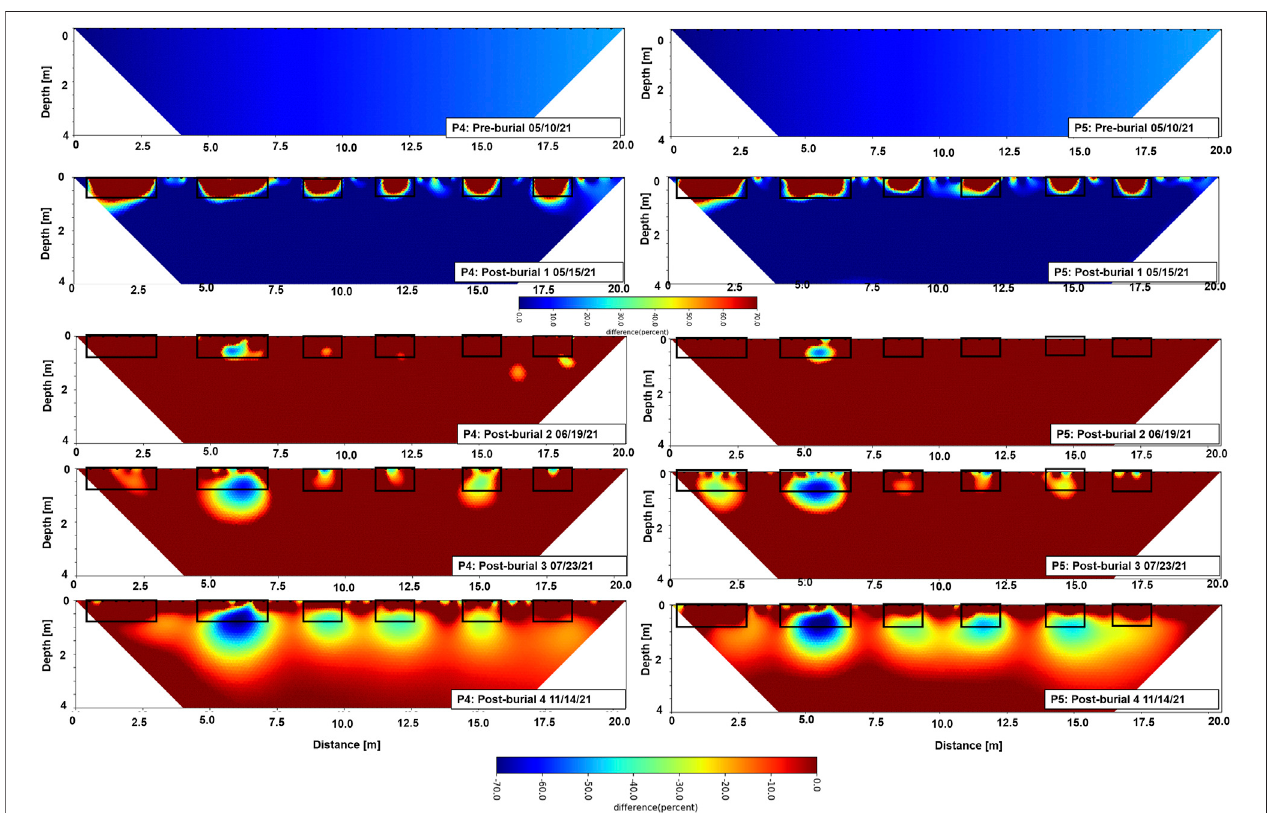
FIGURE8| 2Dtime-lapseresistivitydistributionoffortransects 4(left)and5(right)cuttingacrossallgraves. Percentagechangeswerecalculatedasthedifference between the original measurements on undisturbed ground minus the measurements over the burials, divided by the original measurements. It is to be noted that the scale for the top rows is limited to negative values, while that for the bottom pro fi les shows positive values.